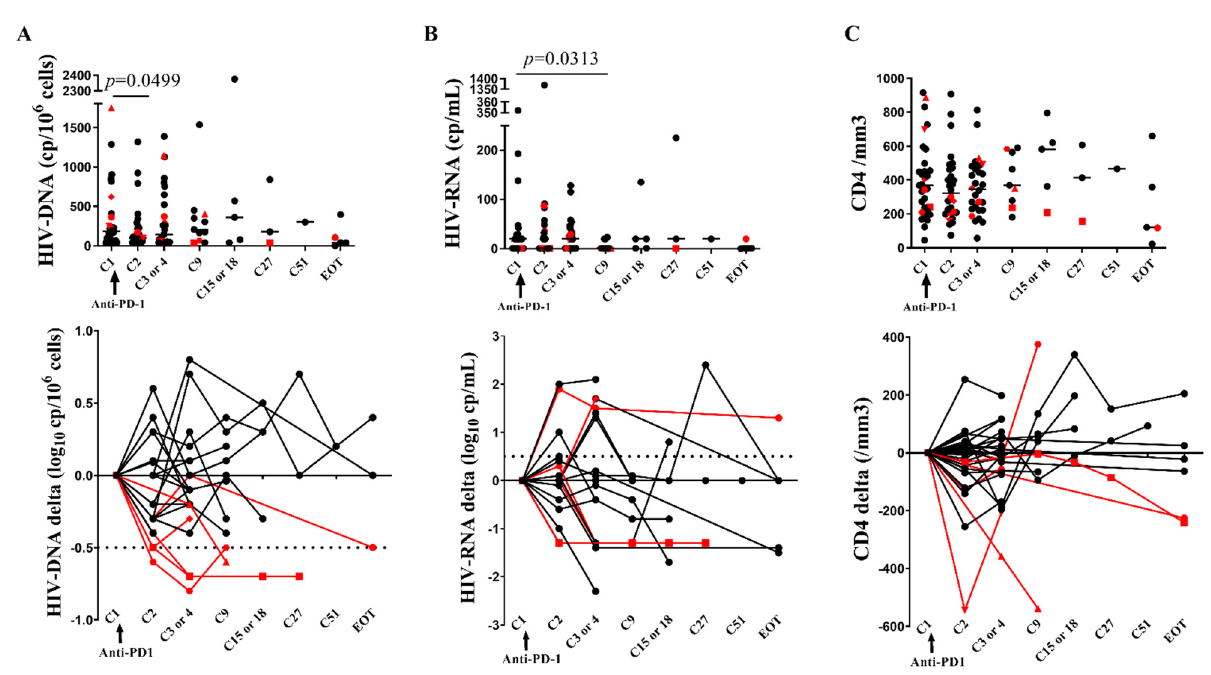
Figure 1. Anti-PD-1 therapy in PLWH with cancer does not significantly impact the biology of HIV. ( A ), HIV-DNA (cp/10 ^6 cells) (upper panel) and HIV-DNA (log 10 cp/10 ^6 cells) delta from baseline (lower panel), ( B ), HIV-RNA (cp/mL) (upper panel) and HIV-RNA (log 10 cp/mL) delta from baseline (lower panel), ( C ), CD4 count (/mm 3 ) (upper panel) and CD4 count (/mm 3 ) delta from baseline (lower panel). Dotted lines denote decrease ≤ 0.5 log 10 for CA HIV-DNA and increase ≥ 0.5 log 10 for HIV-RNA. Red color denotes the RR patients represented with different shapes. EOT: end of treatment. Bonferroni corrected p -value: p ≤ 0.007, Wilcoxon-matched pairs signed Rank test. At cycle 1, n = 32; at cycle 2, n = 29; at cycle 3 or 4, n = 29; at cycle 9, n = 11; at cycle 15, n = 5; at cycle 27, n = 3; at cycle 51, n = 1; at end of treatment, n = 5. Experiments were monoplicates.